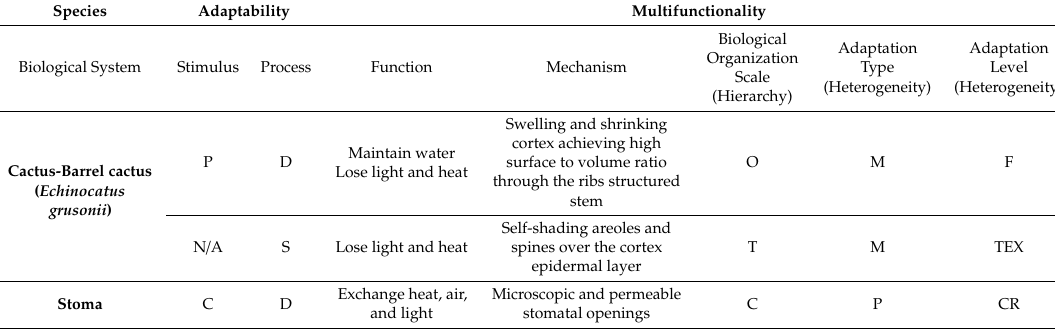
Table 5. Echinocactus grusonii and its properties. (in stimulus P: physical, C: chemical; in process D: dynamic, S: static; in biological organization scales O: organ, T: tissue, C: cell; in adaptation types M: morphological, P: physiological; in adaptation levels F: form, TEX: texture, CR: chemical response; N / A: Not